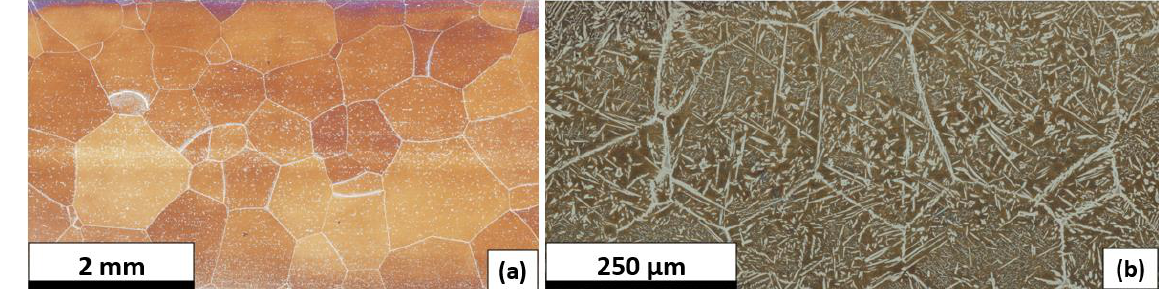
Figure 13. Microstructures of ( a ) the skin and ( b ) the core of a solution-treated sample. Ferrite grains appear in dark and austenite ones appear in light.